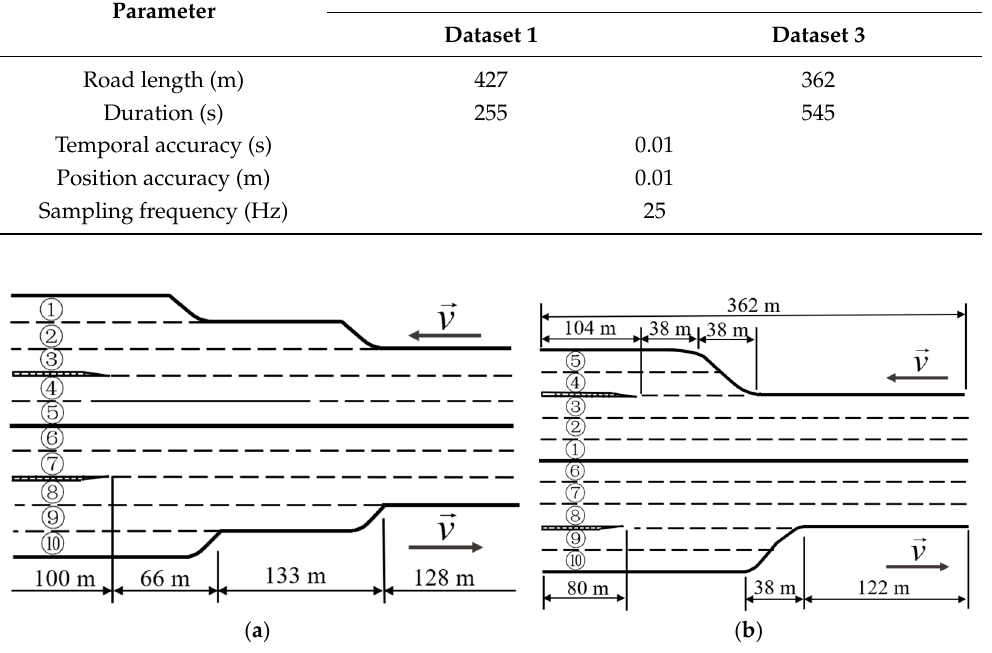
Table 1. Introduction of natural driving vehicle trajectory database.